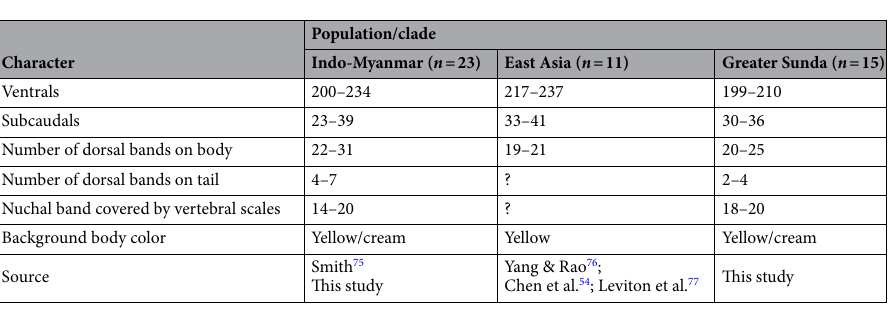
Table 2. Some comparative morphological data of Bungarus fasciatus sensu lato in each biogeographic region, based on this study and published data.